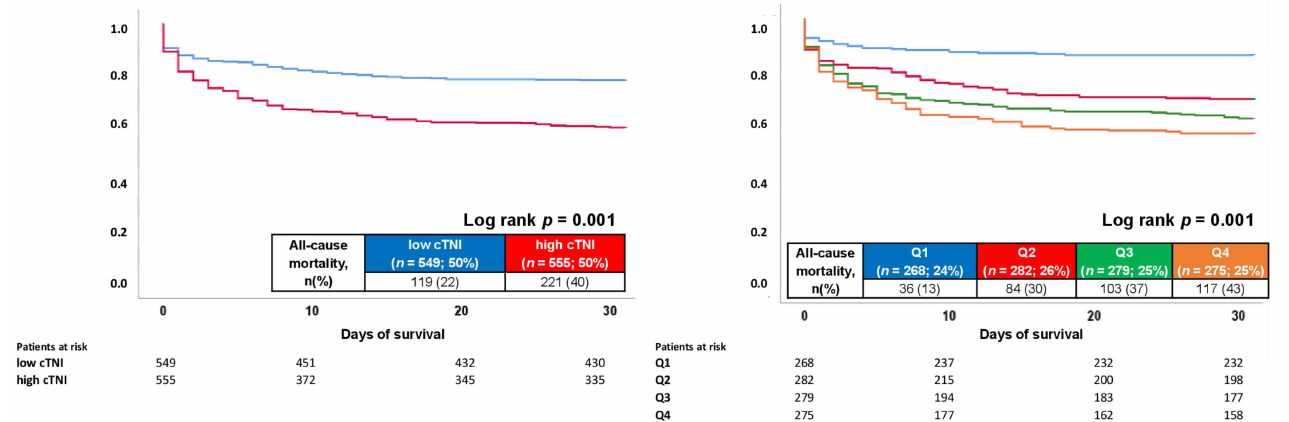
Figure 3. Kaplan–Meier analysis comparing patients with high cTNI to patients with low cTNI ( left panel), as well as within a quartile analysis ( right panel), with regard to 30-day all-cause mortality (primary endpoint) within the entire unmatched study cohort. Accordingly, elevated cTNI levels were associated with increased 30-day all-cause mortality (primary endpoint) in patients with ventricular tachyarrhythmias (HR = 2.004; 95% CI 1.603–2.505; p = 0.001) (Table 3, left). Furthermore, cardiac death was more common in patients with high cTNI (31% vs. 17%; p = 0.001). In line with this finding, higher rates of all-cause mortality at 24 hours (22% vs. 13%; p = 0.001) and 30 months (52% vs. 38%; p = 0.001) were seen in patients with high cTNI. The risk of the composite arrhythmic endpoint (i.e., recurrent ventricular tachyarrhythmias, appropriate ICD therapies and SCD) and cardiac rehospitalization at 30 months were not affected by cTNI within the unmatched study cohort. Notably, median intensive care unit (ICU) time was longer in patients with high cTNI (4 days (interquartile range (IQR) 2–10 days) vs. 4 days (IQR 1–8 days); p = 0.001), along with a shorter median follow-up time (624 vs. 1079 days) (Table 3, left